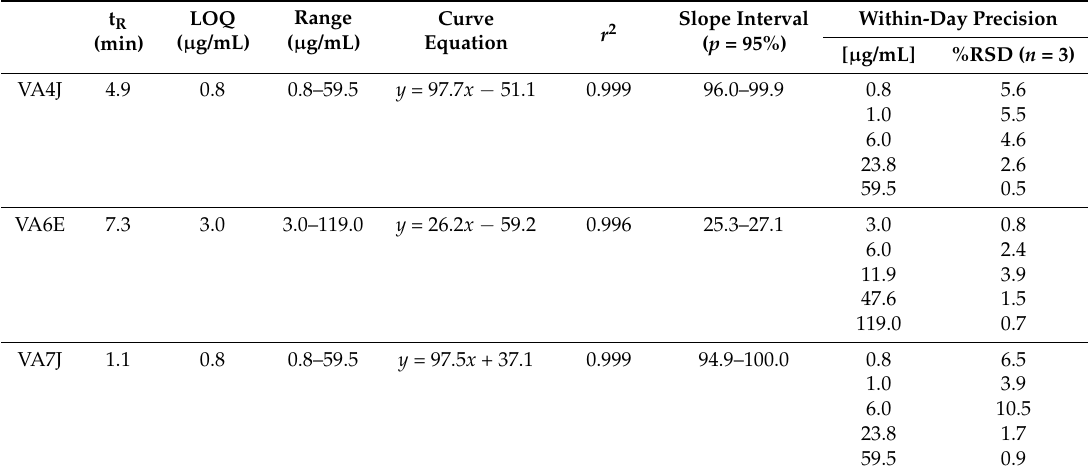
Table 6. Limit of Quantification (LOQ), linearity data and within-day precision.